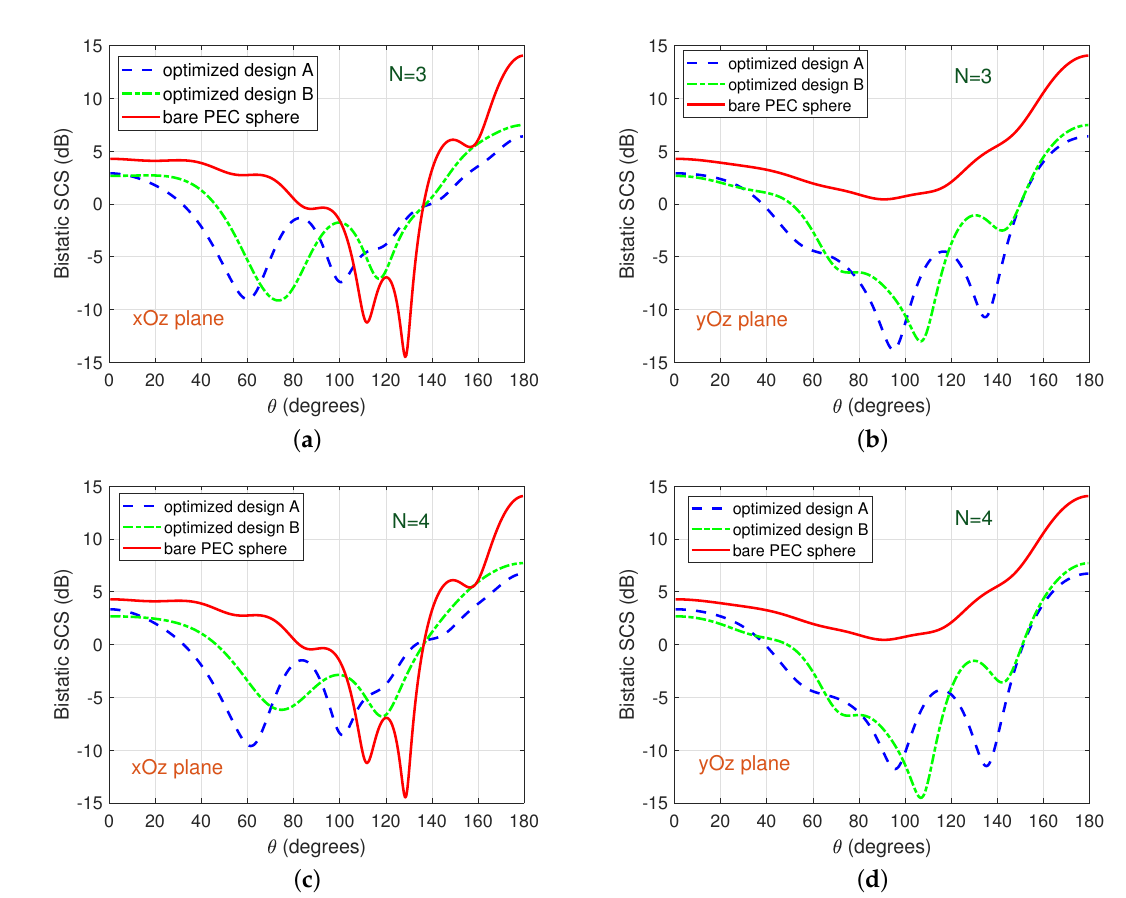
Figure 4. As in Figure 2 with ( a , b ) N = 3 and ( c , d ) N = 4, but for a dipole at b = 1.3 a 1 , near the boundary of the spherical medium. The values of the optimization variables for designs A and B are given in Table A2 of the Appendix